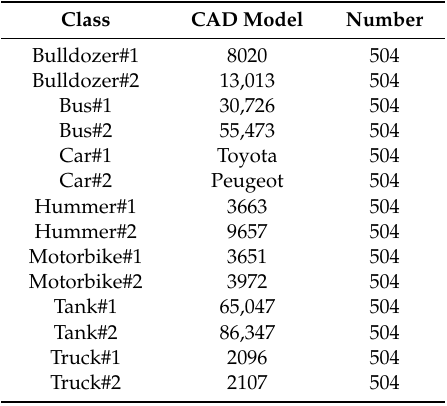
Table 3. Description of the simulated SAR dataset.